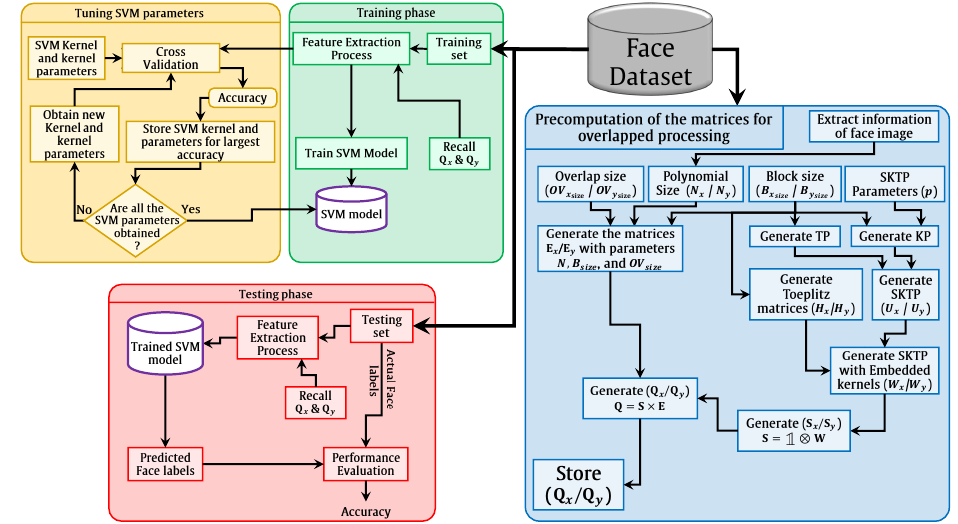
Figure 1. Flow diagram of the presented face recognition